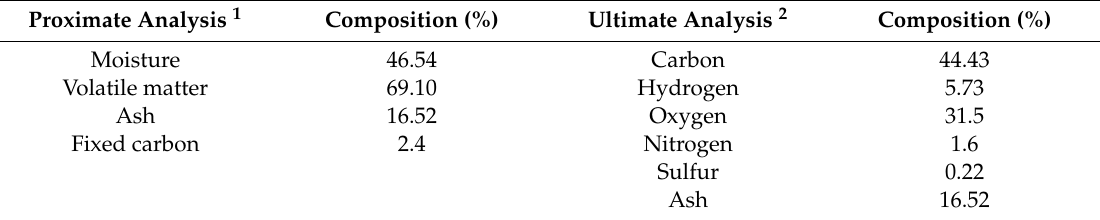
Table 1. Proximate and ultimate analyses composition of MSW in